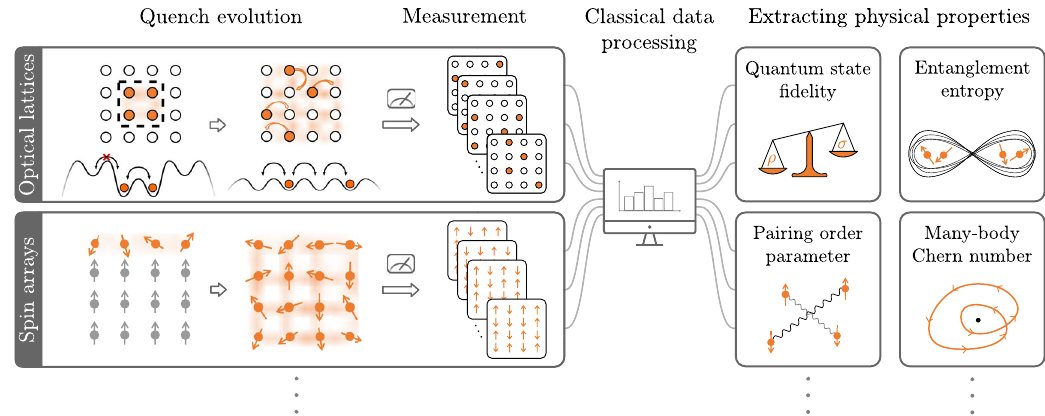
FIG. 1. Schematic illustration of our protocol applied to two representative quantum simulators: itinerant particles in optical lattices (top) and systems of spins (bottom) realized by, for example, arrays of Rydberg atoms. In both cases, we aim to extract properties of an unknown state ρ characterizing the system (orange circles or spins prior to the quench), initially prepared via independent quantum simulation methods. We assume the presence of nearby ancillary sites (empty circles) or spins (gray arrows) which are initially in a known, definite state j ϕ i , decoupled with the system of interest, e.g., via large potential barriers (black dashed box). The first step of our protocol is to allow the systems to interact with the ancillas: the time evolution of the global system generated by the natural Hamiltonian of the analog simulators. This step can be done in many ways; examples include lowering the potential barrier (itinerant particles in optical lattices) or by shuttling the ancilla spins closer to the system using optical tweezers (Rydberg atoms). This quench evolution scrambles information from the system to the ancillary degrees of freedom and typically entangles them in the process. The second step is to take snapshots of the extended system in some fixed basis, e.g., the particle occupation number or spin-polarization bases. Arbitrary desired observables of the initial state ρ can then be extracted through a final classical data-processing